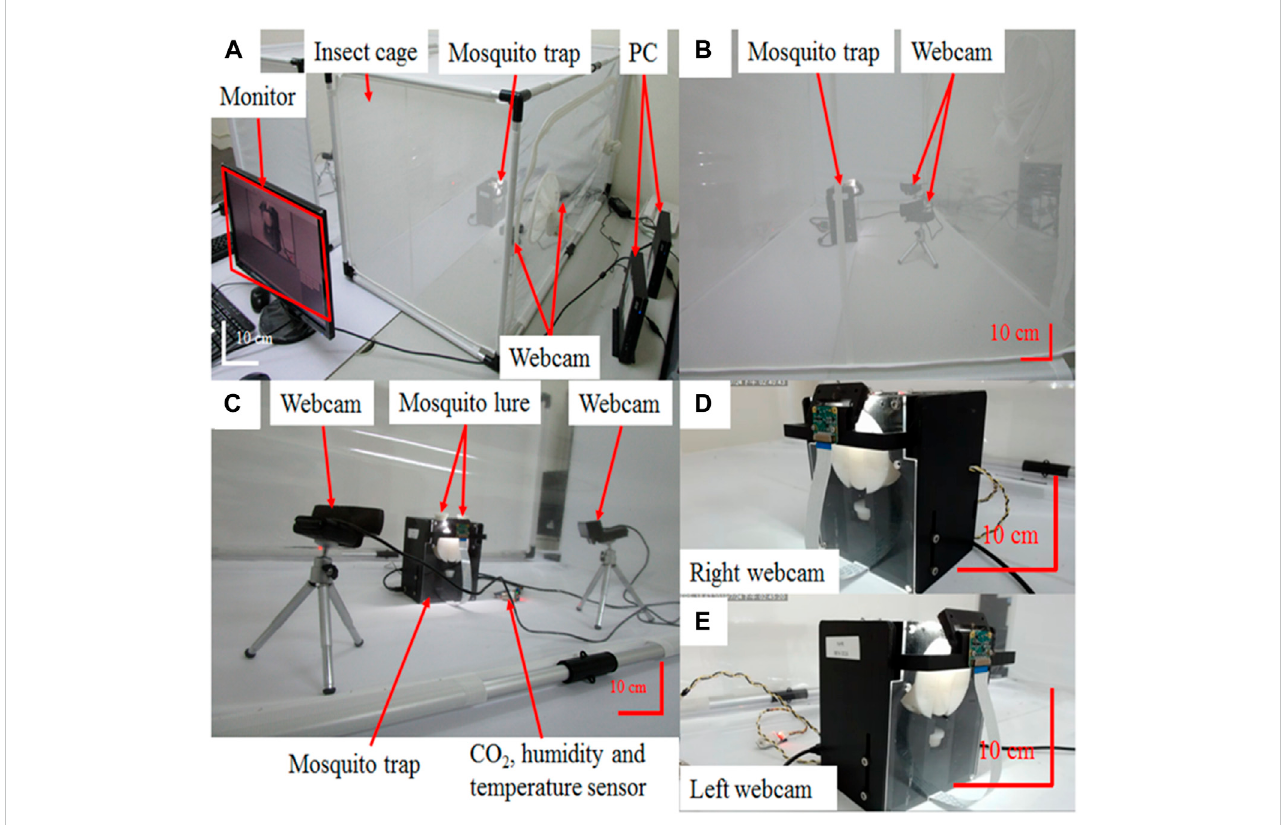
FIGURE 5 Performancetest of the core device of thedeveloped mosquito trap to identify and classify mosquitoes. (A) The mosquito trap set up for a live mosquito capture test.PCs and camerasare placed ontheleftand rightsides ofthemosquito trap, and thescreen displays thecapturedimage. (B,C) Mosquitotrap and two cameras in the mosquito net. (D,E) Real-time image of the mosquito trap core device from the right (Supplementary Movie S7) and left (Supplementary MovieS8)sidesofthemosquitotrap.Thecamerarecordedthestatusesofmosquitoes andmosquitotrapsin fl ight.Aftereachexperiment,themosquito data were recorded, and statistical data were used to calculate the capture rate and recognition rate of the experiment.